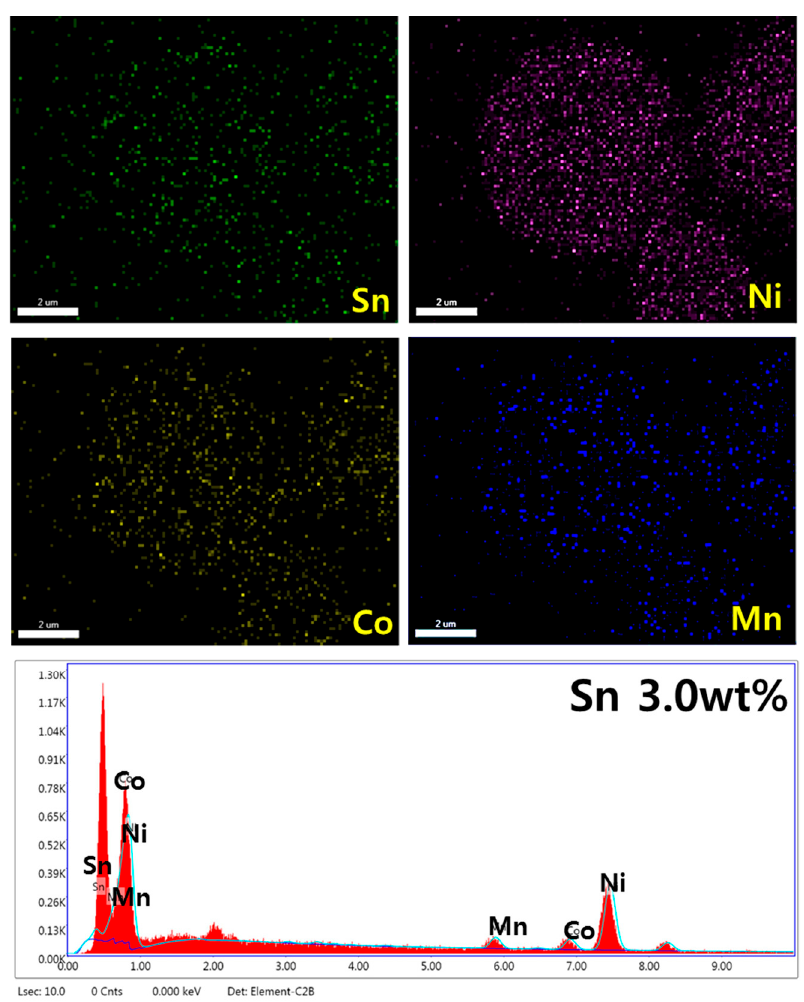
Figure 2. EDS (energy dispersive X-ray spectroscopy) cross-section mapping of the Sn 3.0 wt % cathode active materials.